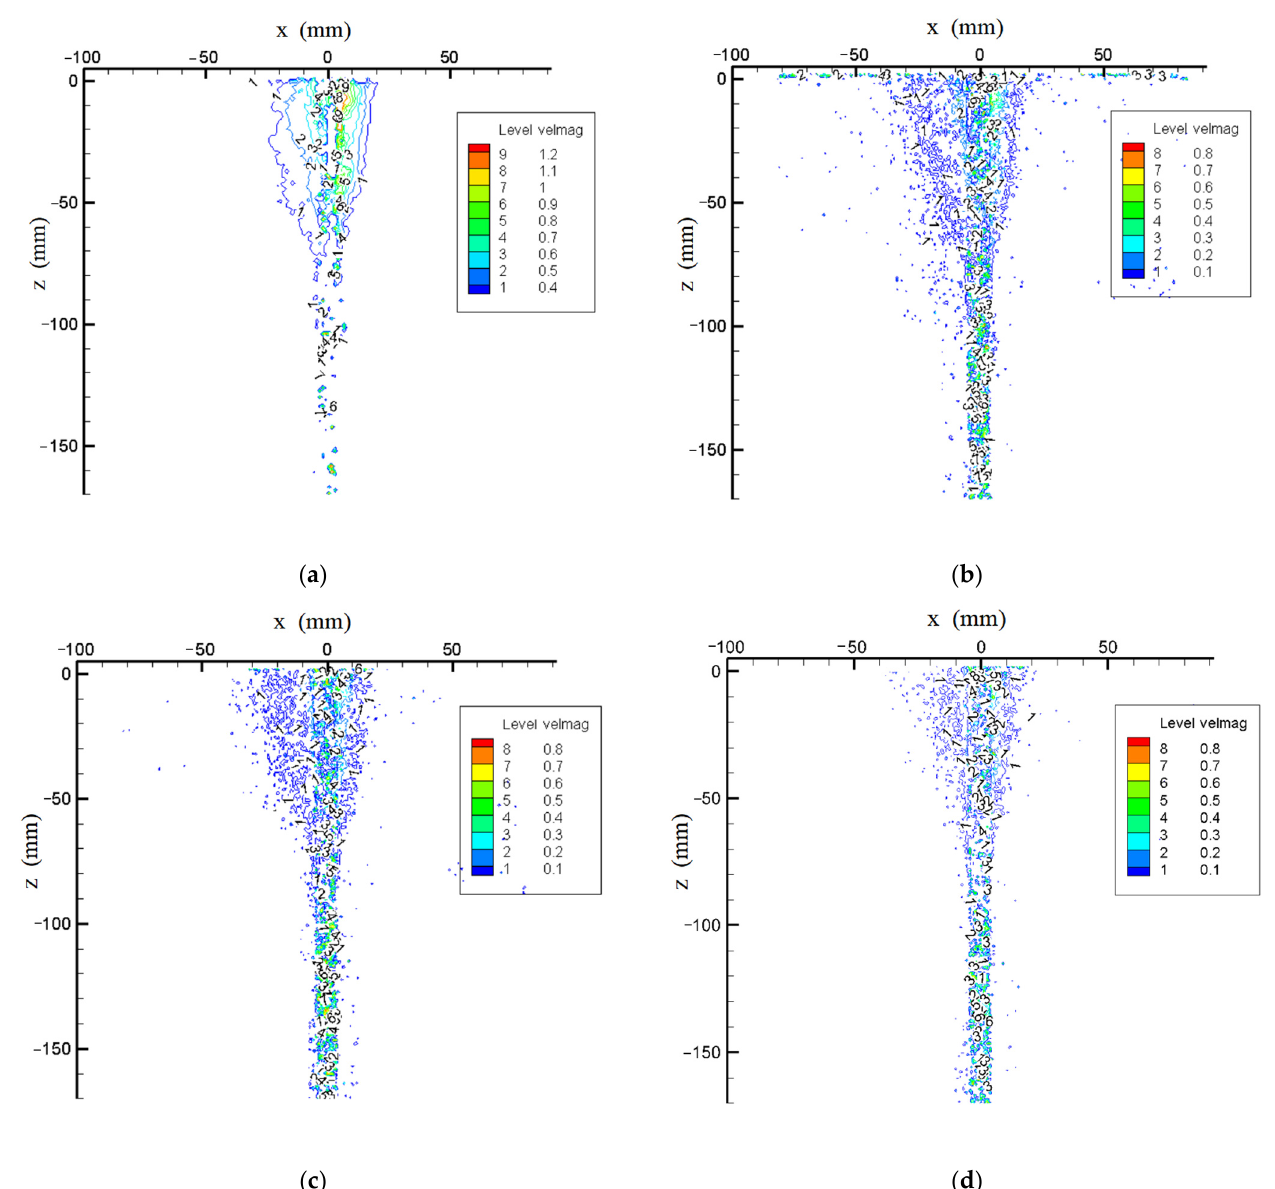
Figure 13. PIV displacement image after cyclic loading of 90 mm groundwater depth test. ( a ) After the first cyclic loading. ( b ) After the second cyclic loading. ( c ) After the tenth cyclic loading. ( d ) After the twentieth cyclic loading.